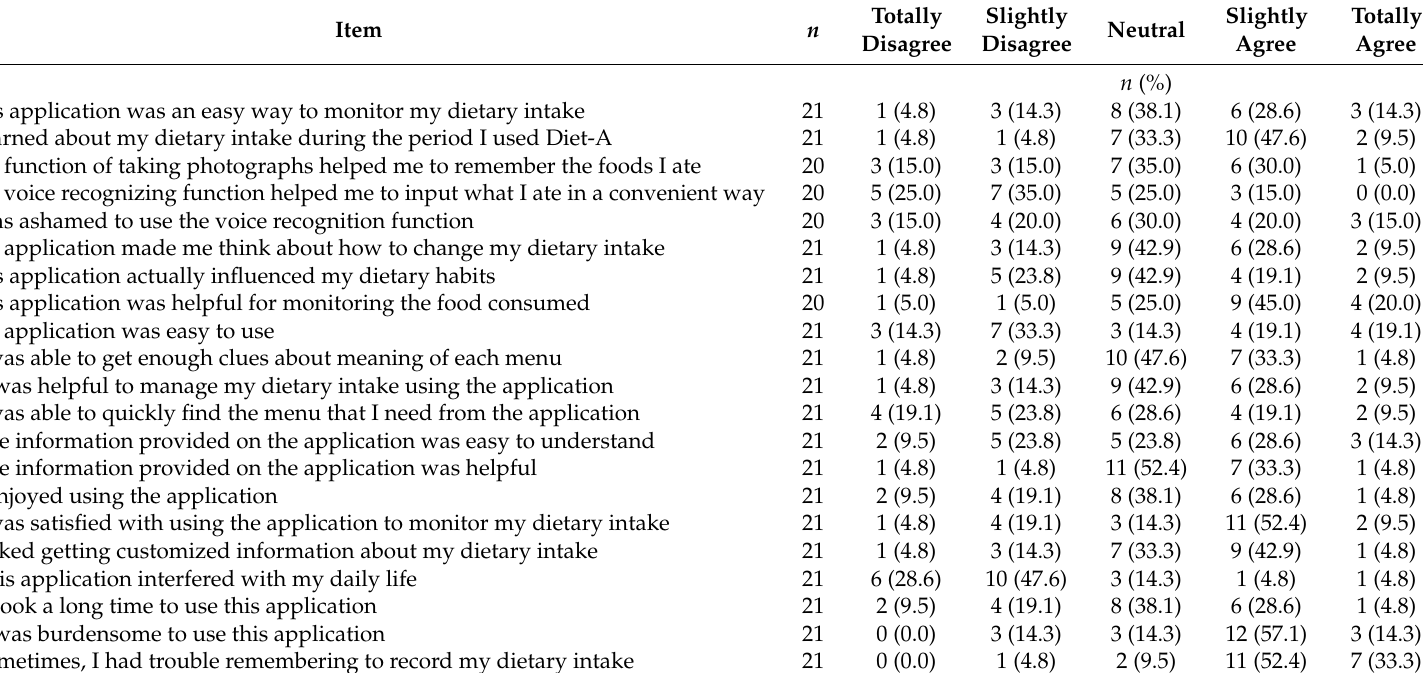
Table 4. Agreement with items on the feasibility questionnaire about Diet-A use among application users ( n =